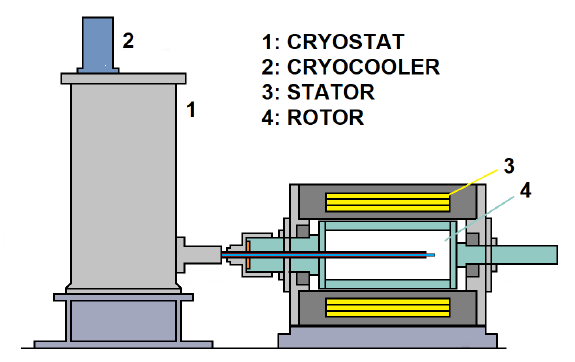
Figure 1. Electric machine with rotating cryostat for rotor cooling.